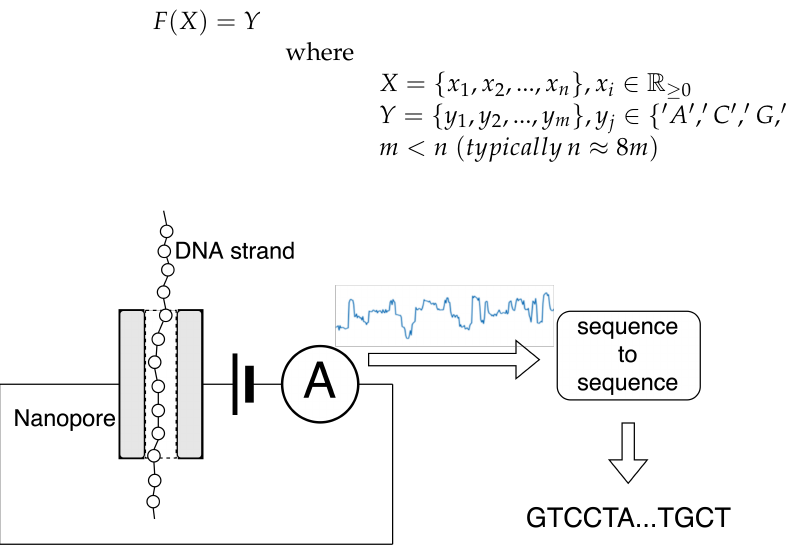
Figure 1. Illustration of the working principle of a nanopore DNA sequencer used in our